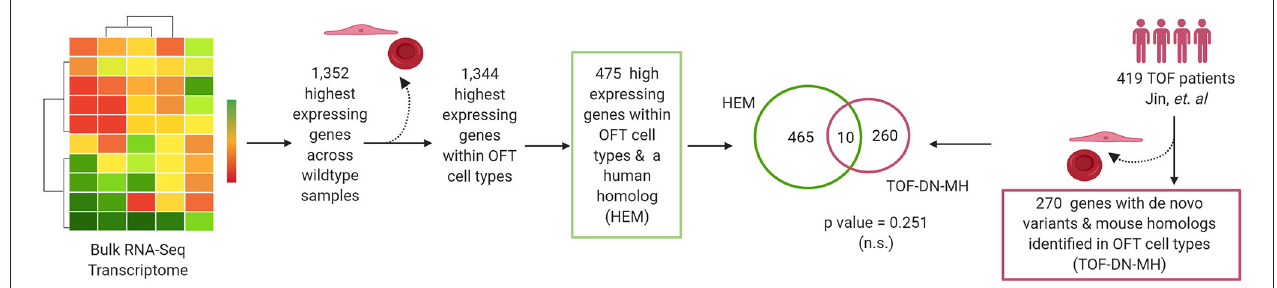
FIGURE 6 | Highest expressed genes in cardiac outflow tract identified by RNA-Seq are not predictors of de novo variants in tetralogy of Fallot (TOF) cohorts. The highest expressing genes ( n = 1,352) across all three wildtype mouse outflow tract (OFT) samples were selected. Of these ( n = 475) were expressed with OFT cell types and also possessed a human homolog. We assessed the overlapped the TOF-DN-MH gene list with the HEM gene list in OFT cell types and determined no enrichment of genes between these datasets ( p -value = 0.251). Figure was generated on www.Biorender.com. to validate the bioinformatic conclusions we generated